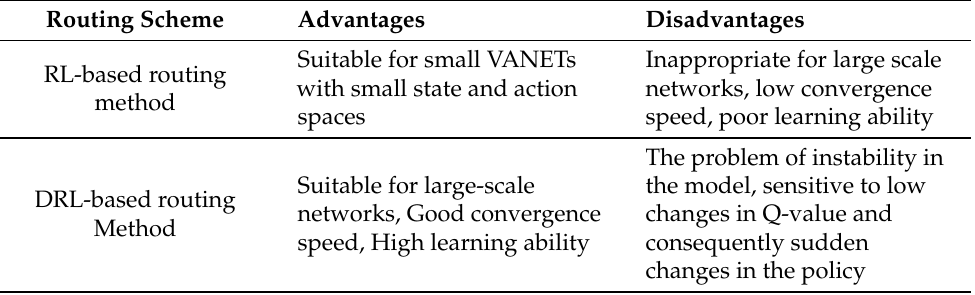
Table 5. RL and DRL-based routing schemes.